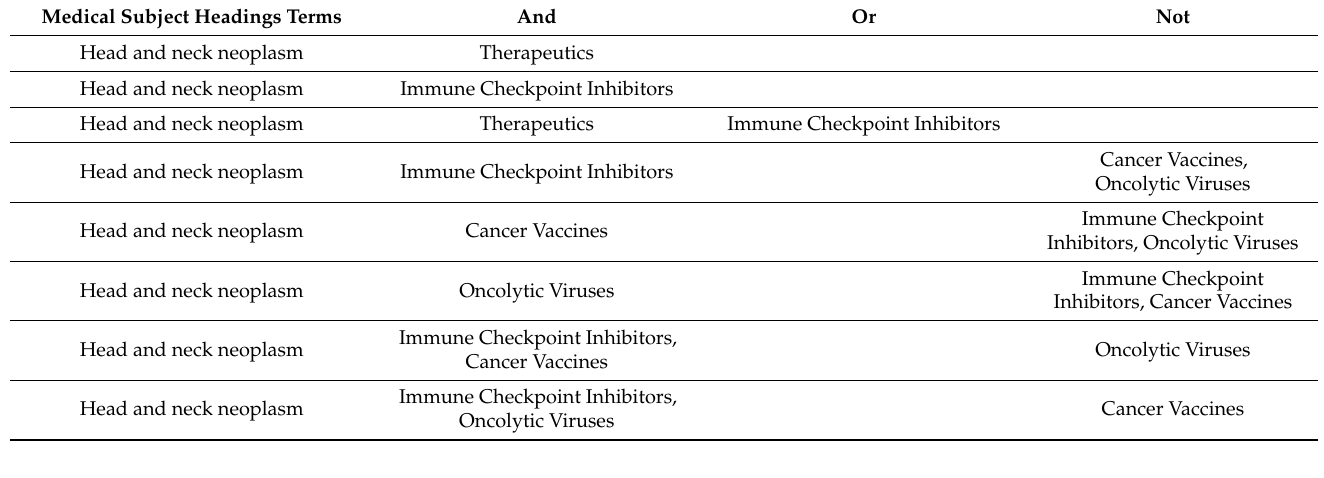
Table 1. Strategy used for the combination of keywords (Medical Subject Headings terms) to obtain the literature used in this review.